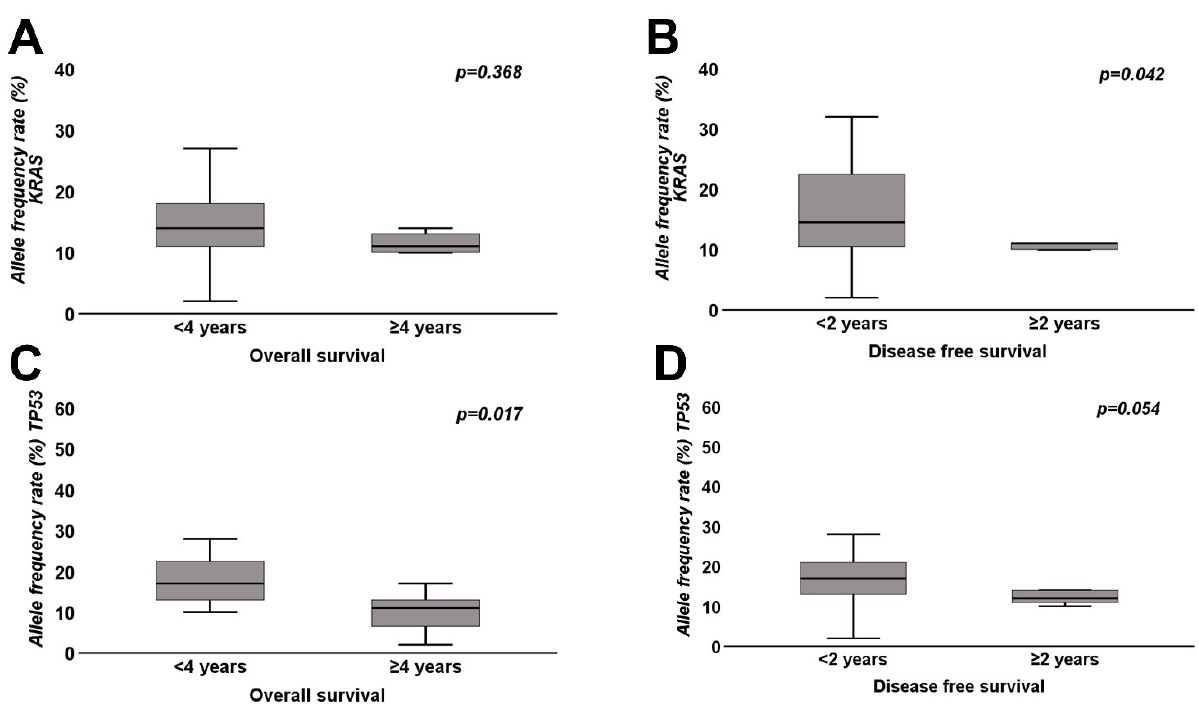
Figure 6. Box plots of ( A ) KRAS allele frequency rate and overall survival ( n = 39). ( B ) KRAS allele frequency rate and disease-free survival ( n = 39). ( C ) TP53 allele frequency rate and overall survival ( n = 39). ( D ) TP53 allele frequency rate and disease-free survival ( n = 39). Mann–Whitney U tests were used to test for significance ( p -value < 0.05 indicates significance). Table 4. Correlation analysis between survivor subgroups and median allele frequency rates of pathogenic KRAS and TP53 mutations. A Mann–Whitney U test was used to test for significance ( p - value < 0.05 indicates significance).